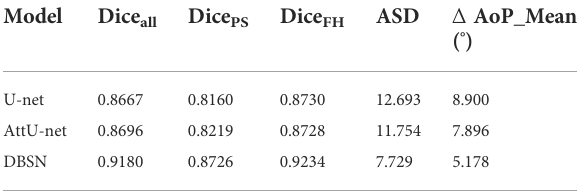
TABLE 2 Comparison of computed AoPs of different algorithms. TABLE 3 Performance of different methods on the public JNU-IFM